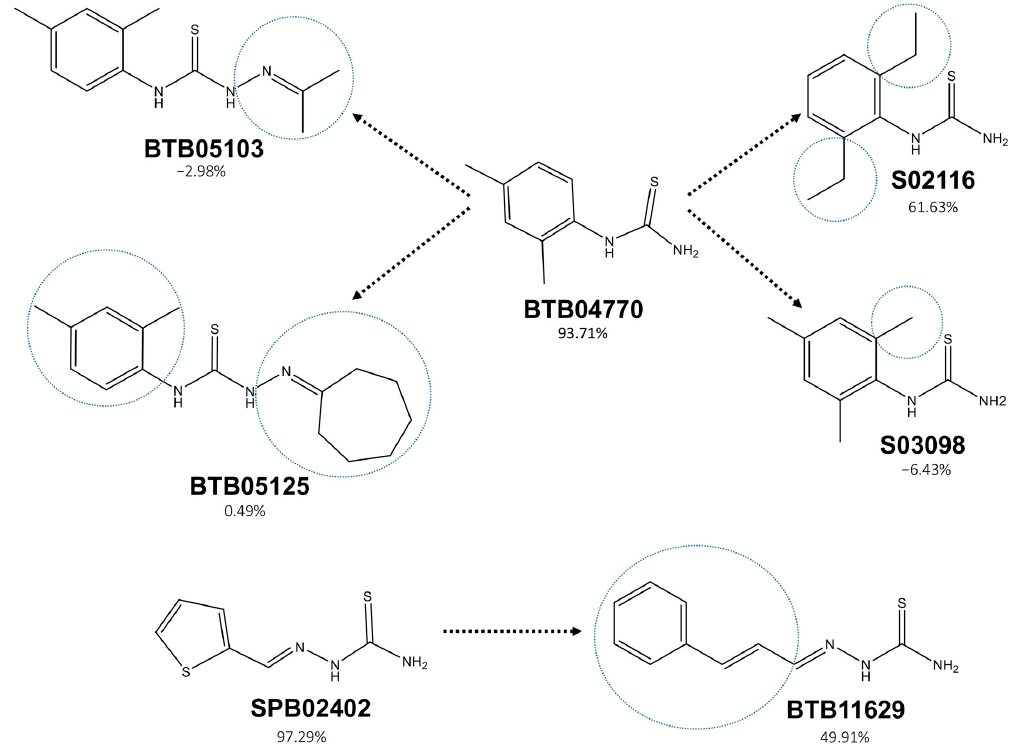
Figure 5. Activity cliffs of the molecules tested in the tyrosinase inhibition assay are presented. The tyrosinase inhibition activities of the two representative chemicals (BTB04770 and SPB02402) are compared with the other chemicals in terms of their activity changes. The blue dotted circles exhibit the structural difference(s) between the molecules. The tyrosinase inhibition percentage of every molecule is given.